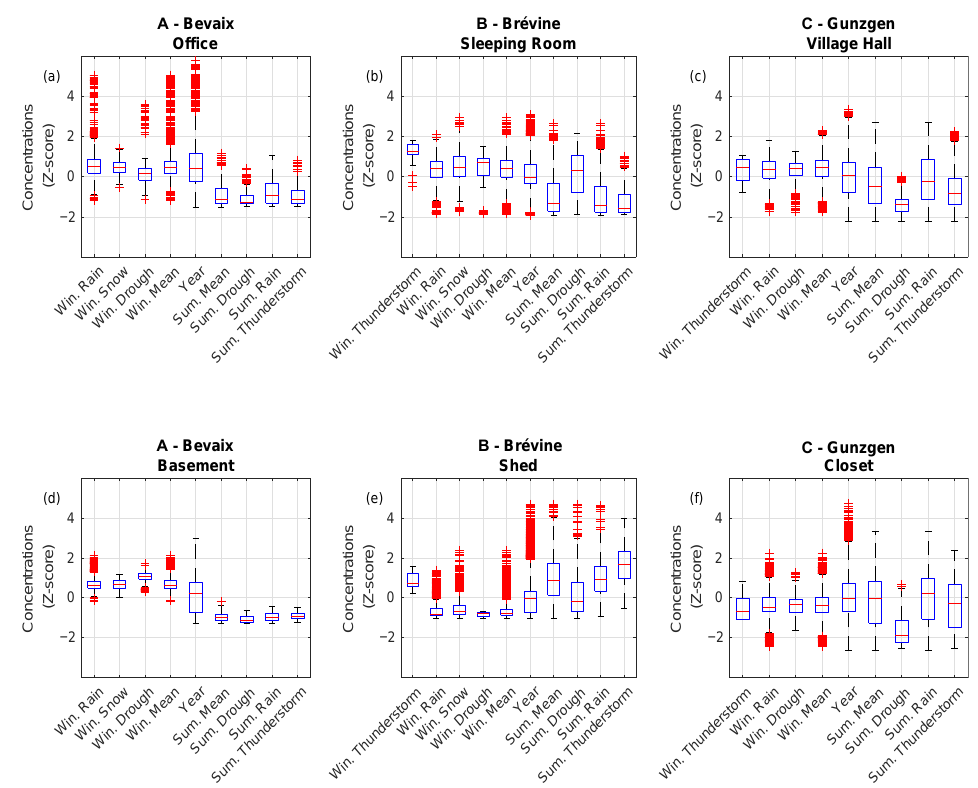
Figure 4. Box-plots synthesizing the impacts of precipitation on IRC at Bevaix ( a , d ), La Brévine ( b , e ), and Gunzgen ( c , f ). Occupied spaces are shown in ( a – c ) and unoccupied spaces in ( d – f ). Different precipitation events are given for both winter and